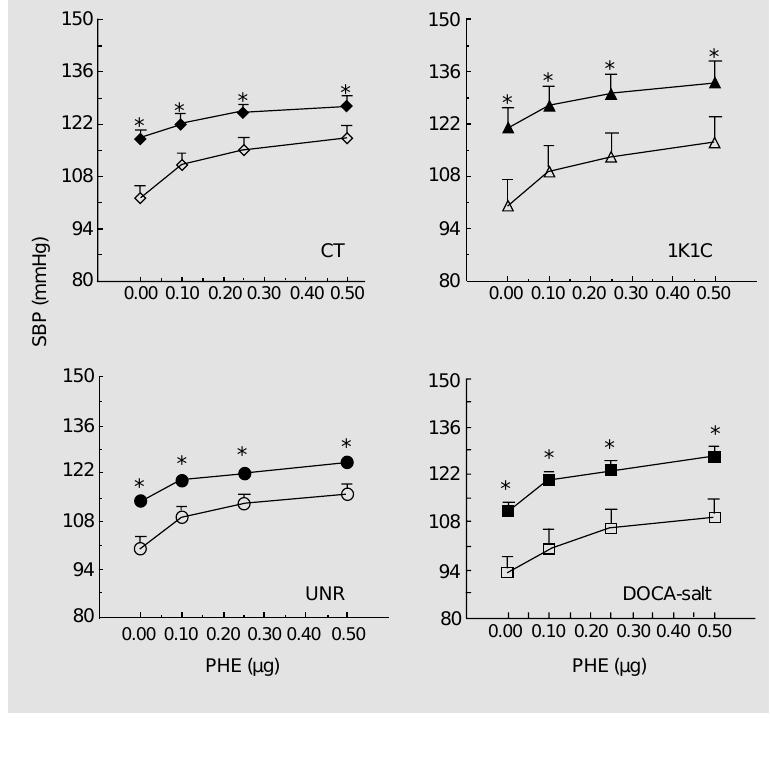
Figure 3. Changes in diastolic blood pressure (DBP) in response to increasing doses of phenylephrine (PHE) in normotensive (control, CT; uninephrectomized, UNR) and hypertensive (1K1C and DOCA-salt) rats before (open symbols) and after (closed symbols) treatment with 18 µg/kg ouabain. Points represent the means ± SEM. *P<0.05 compared to before ouabain treatment